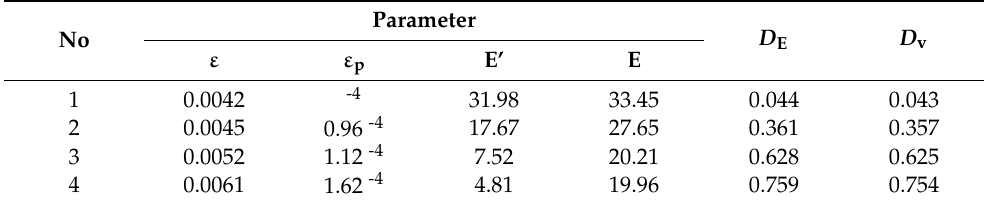
Table 8. Initial damage value determined by the loading-unloading and longitudinal wave speed. No